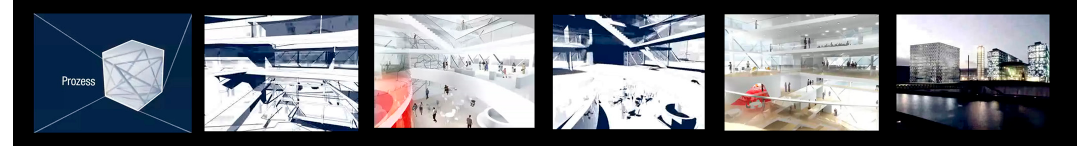
Figure 6. 3XN, Cube, Berlin. Movie by Cadpeople (Edinburg, TX, USA) (3:41),